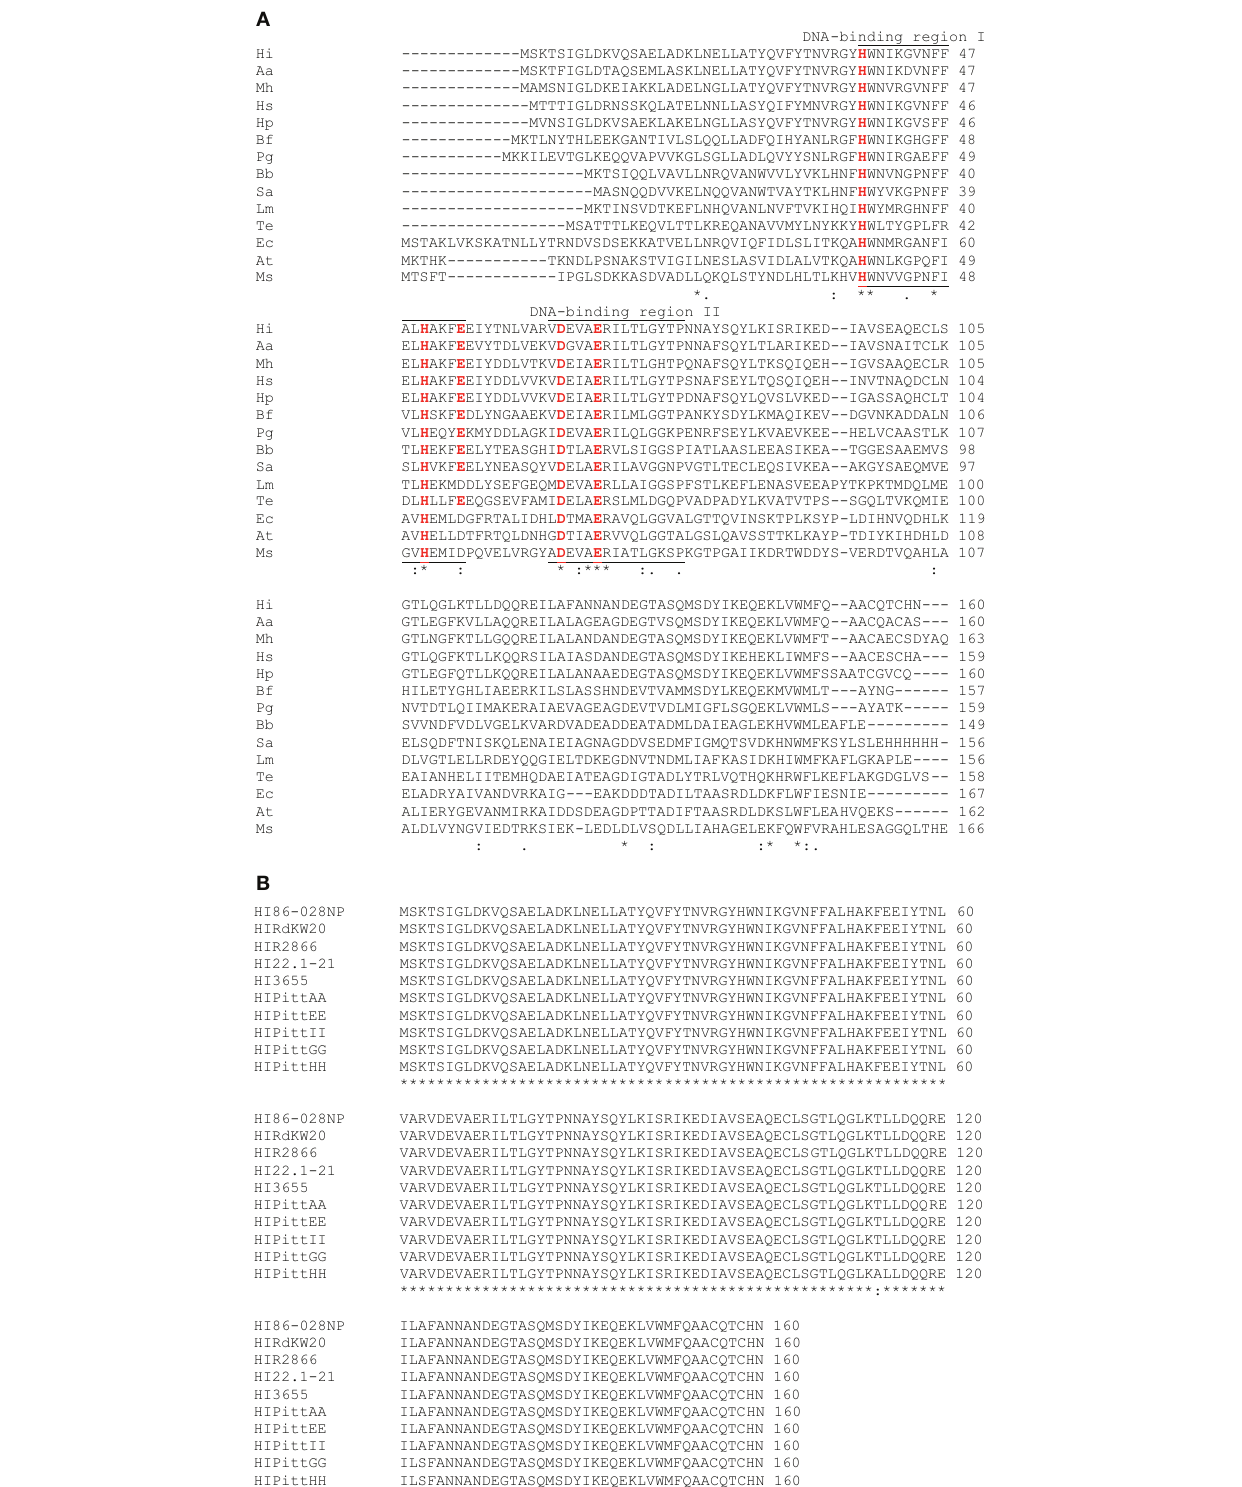
Frontiers in Cellular and Infection